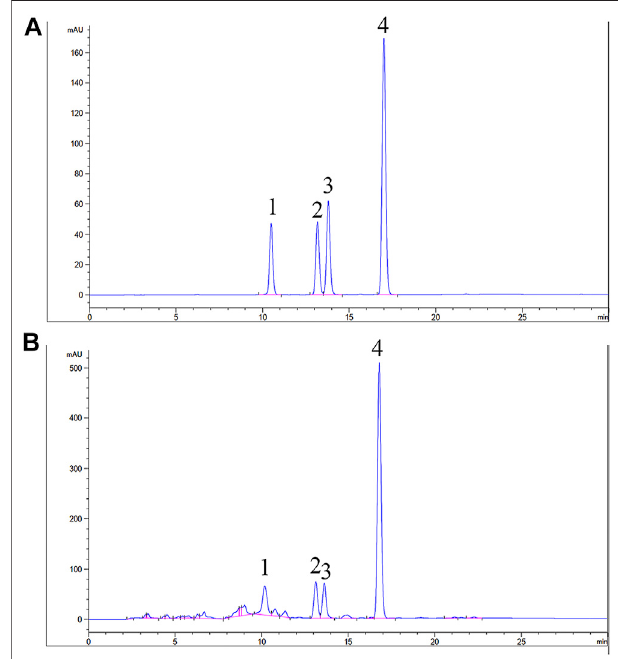
FIGURE 2| High-performance liquid chromatography chromatogram of A:standard mixture of 1:Diydrotanshinone Ⅰ , 2:Tanshinone Ⅰ , 3: Crytotanshinone, 4: Tanshinone IIA, B:TAN